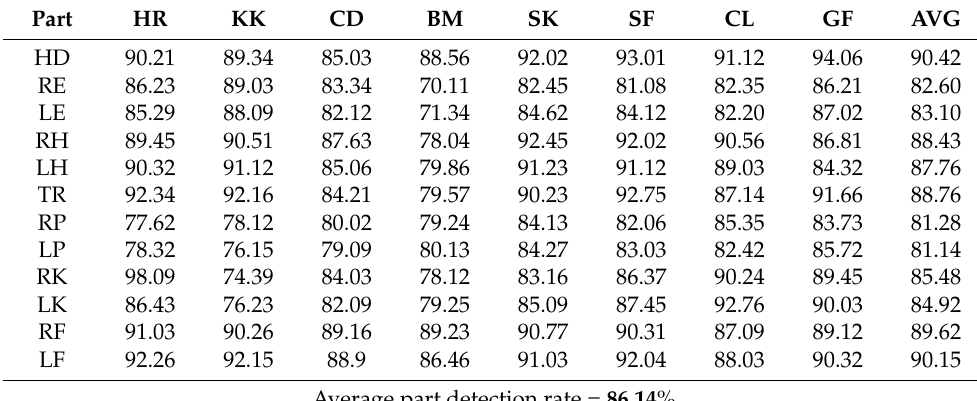
Table 5. Results of body part detection over the YouTube Aerial dataset.